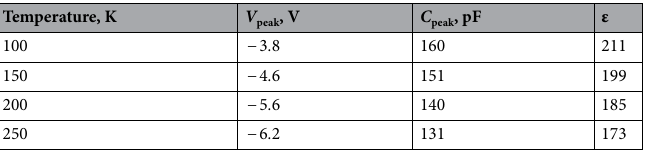
Table 1. Data used for analysis of temperature dependence of ε for the TiO 2 -N 2 sample with CV data plotted in Fig. 1. The implantation depth d peak = 0 . 97 µm. The diode area A = 8.3 × 10 –4 cm 2